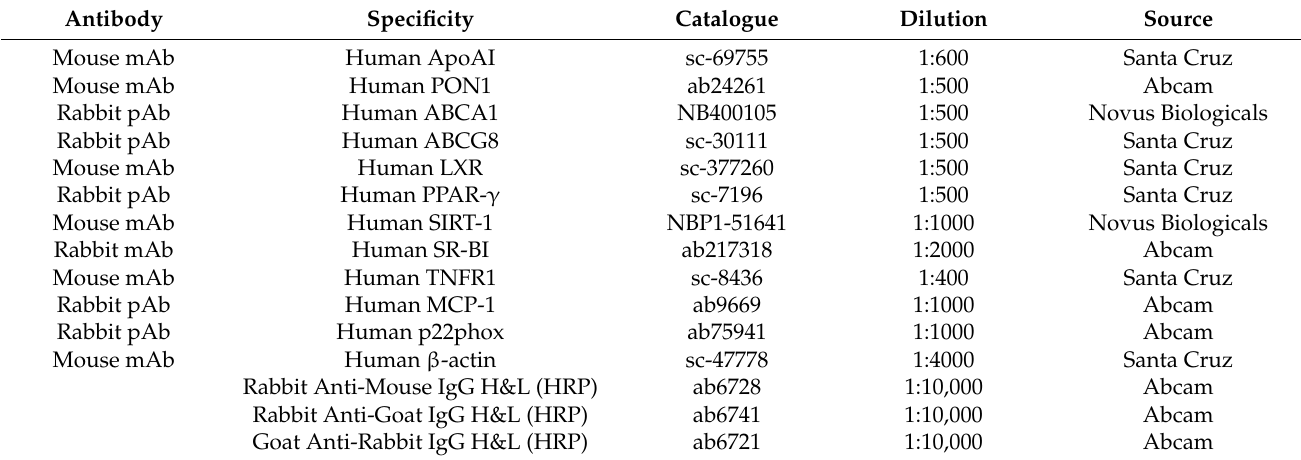
Table 2. Antibodies used for Western blot